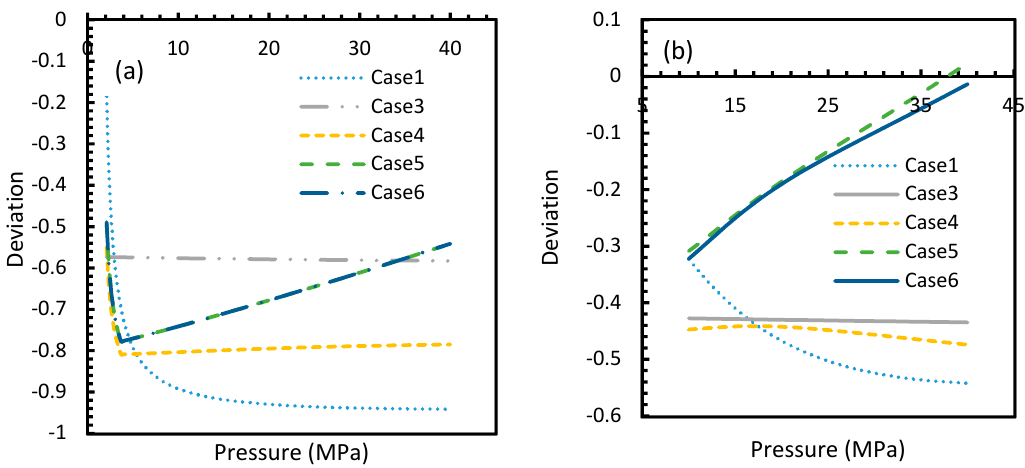
Figure 18. Profiles of deviations of theoretical induction times of CO 2 ( a ) and CH 4 ( b ) under various